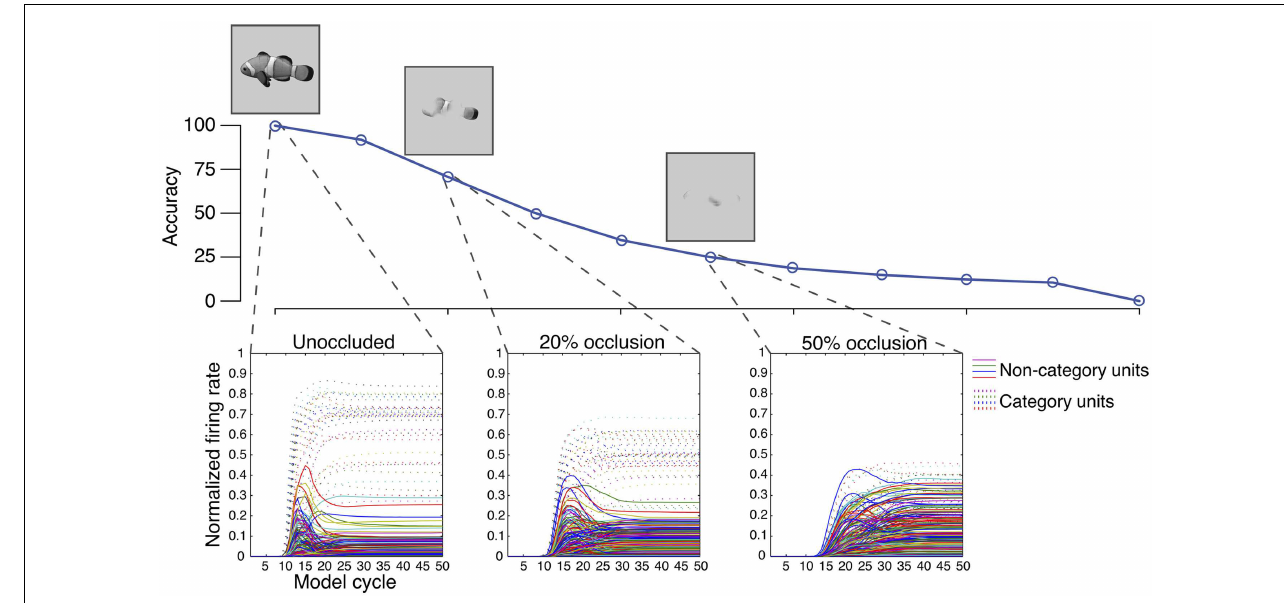
exemplars (dotted lines) or tuned to other categories (solid lines).The first wave of responses from the model’s IT units area code a large number of features, only some of which are category-relevant. Inhibitory competition, however, suppresses the responses of irrelevant non-category units, leaving the features coded by relevant category units to compose the final bound representation.This competitive advantage disappears at higher levels of occlusion (e.g., 50% occlusion) due to fewer category-relevant features being specified in the